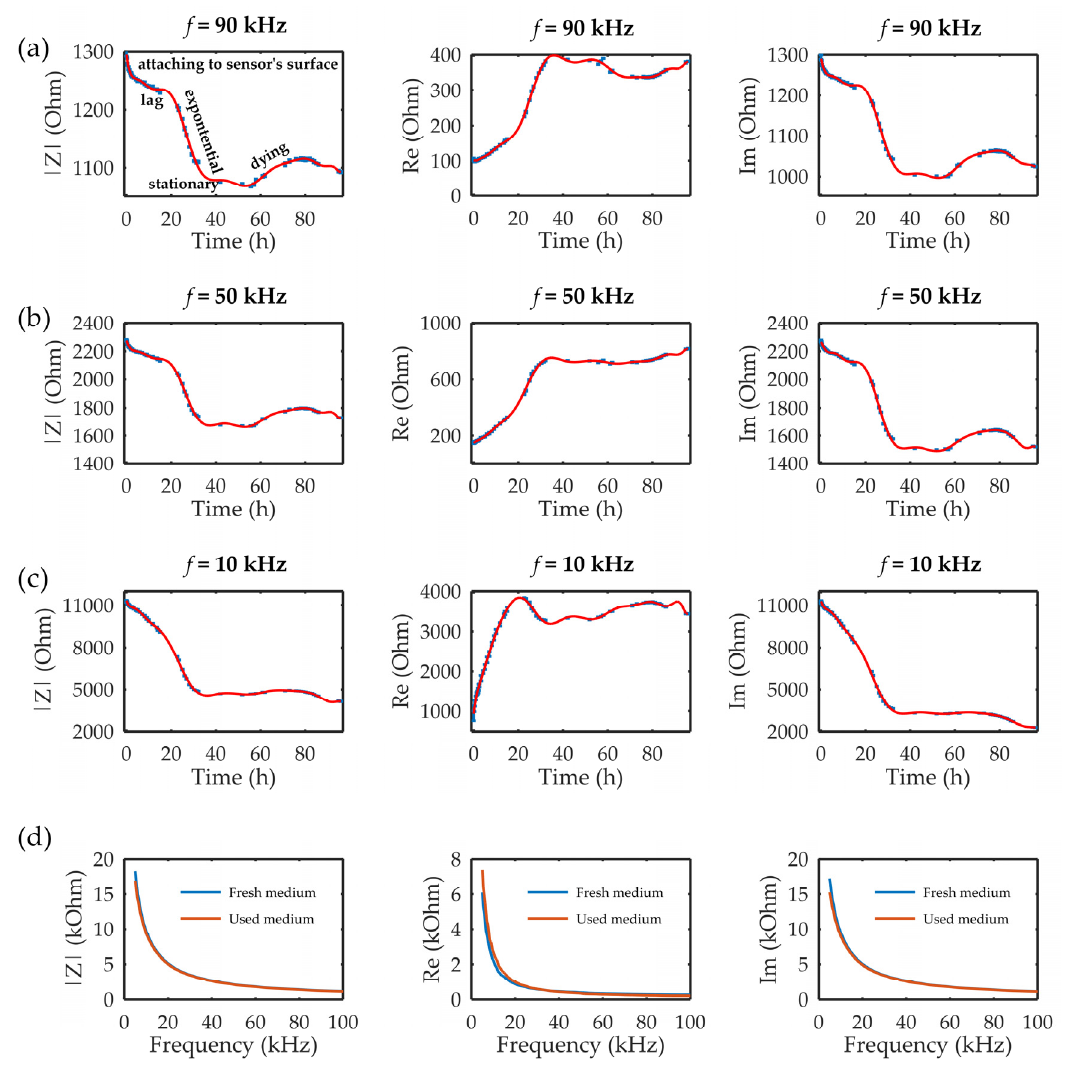
Figure 4. The impedance module (|Z|) and the real (Re) and imaginary (Im) parts of the impedance at three different frequencies in the measured frequency range: ( a ) 90, ( b ) 50, and ( c ) 10 kHz during 96 h of MRC-5 cultivation in the microbioreactor. The error bars in the graph represent standard deviations. ( d ) Control measurements for comparisons of fresh and used medium, i.e., medium after 96 h of cultivation, in terms of |Z| and the Re and Im parts.